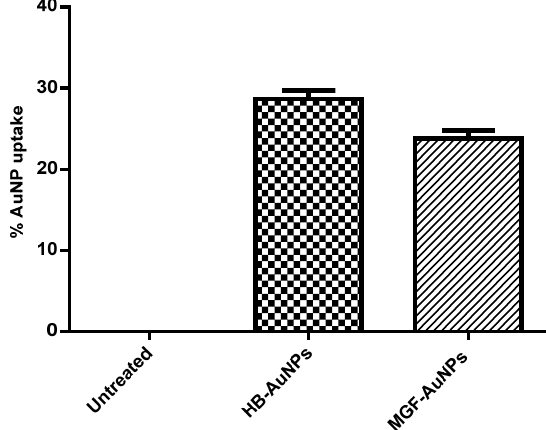
Figure 1. Cellular uptake of AuNPs in Caco-2 cells. Cells were treated for 12 h with HB-AuNPs or MGF-AuNPs, cell lysates were prepared after treatment and Au content within the lysates was determined with ICP-OES. Results are expressed as mean ± standard error of the mean